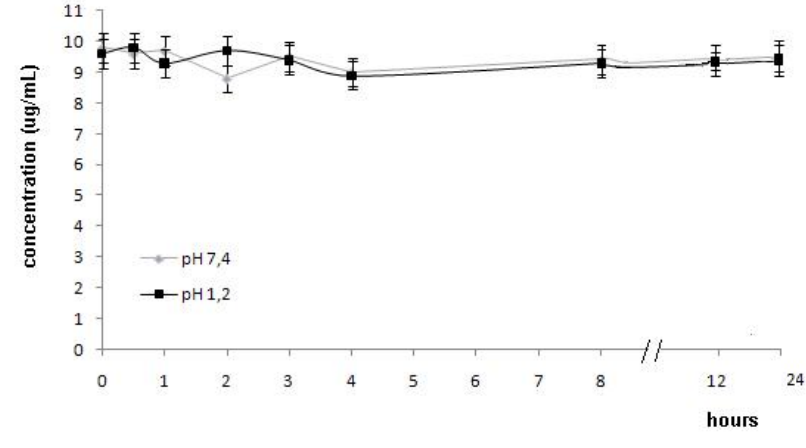
Figure 3. Hydrolysis of lactam derivatives ( μ g/mL) in buffer pH 1.2 and 7.4 (data are represented as mean ± S.E.M., n = 4, P <